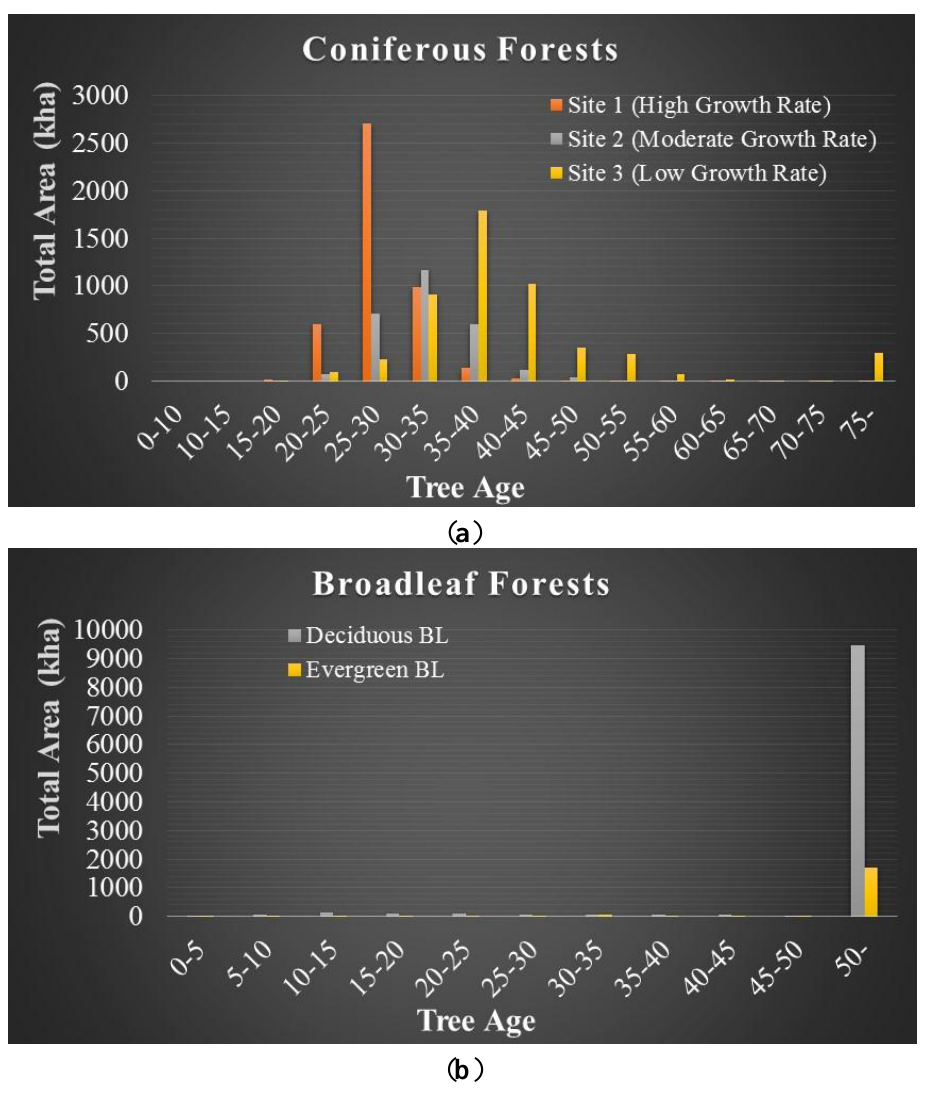
Figure 12. Statistical distribution of forest area by tree age for ( a ) coniferous and ( b ) deciduous/evergreen broadleaf forests in